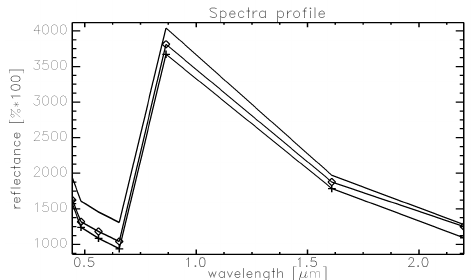
Figure 3: Spectra profiles collected in a cirrus area (no symbol: original; + : 1.38 µ m; ⋄ : CTM) Table 2: Sentinel-2 absolute and relative difference TOA re- flectance mean value and the RMSE for each band.